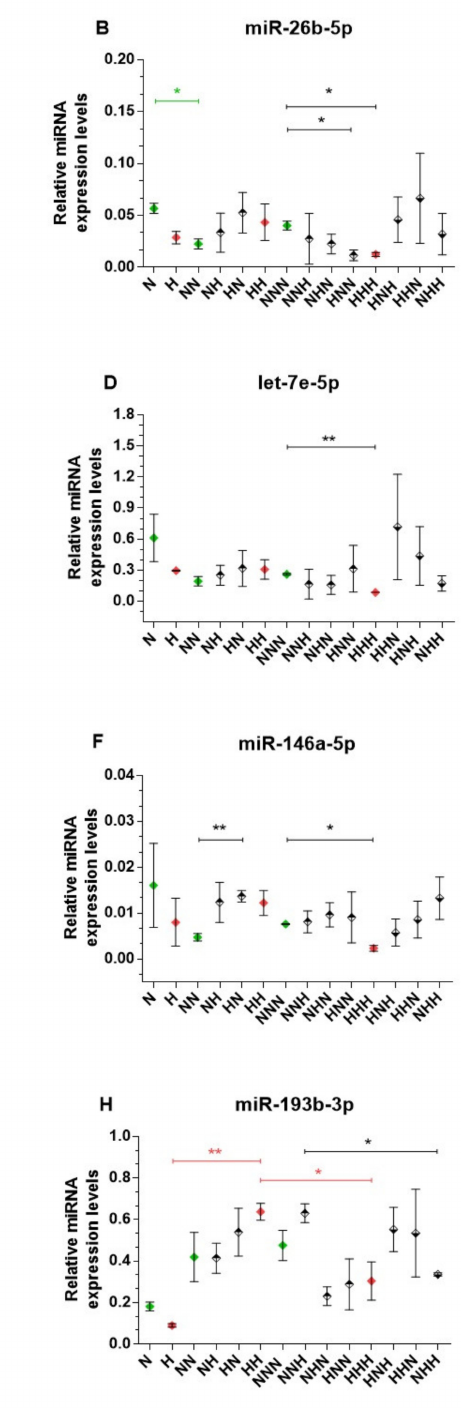
Figure 4. Expression of selected miRNAs in studied cell culture model ( A – H ). Variants differentiated in normoglycemic conditions and chronic hyperglycemia (HG) are colored in green and red, respectively.Variants of transient HG treatment applied during one stage of cell culture are marked with rhombuses with a black upper half and variants exposed to HG during two stages are denoted by rhombuses with a black lower half. Data are presented as mean ± SEM. Significant differences are marked by asterisks according to the p -value criteria: *—0.05 ≥ p > 0.01, **—0.01 ≥ p > 0.001, ***— p ≤ 0.001. Significant differences estimated in one-way ANOVA with a post-hoc Tukey test are marked by green or red asterisks. After the differentiation stage, only miR-146a-5p levels were elevated in HG-treated Ads during the preadipocyte proliferation stage (HN vs. NN, p = 0.004; Figure 4F).